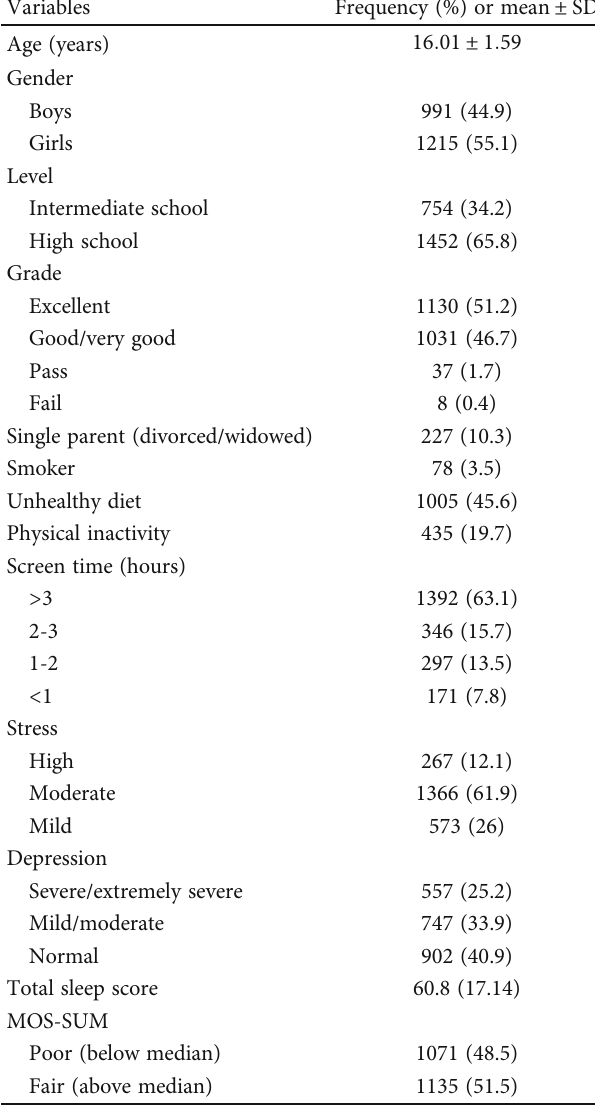
Table 1: Baseline information of the study sample ( N = 2206